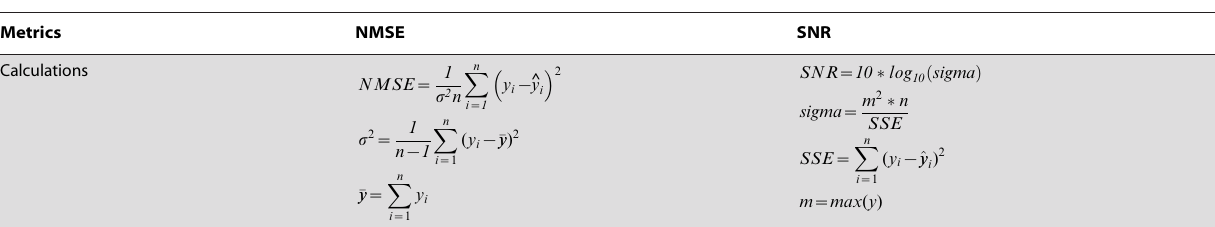
Table 1. Performance Metrics and their Calculations.